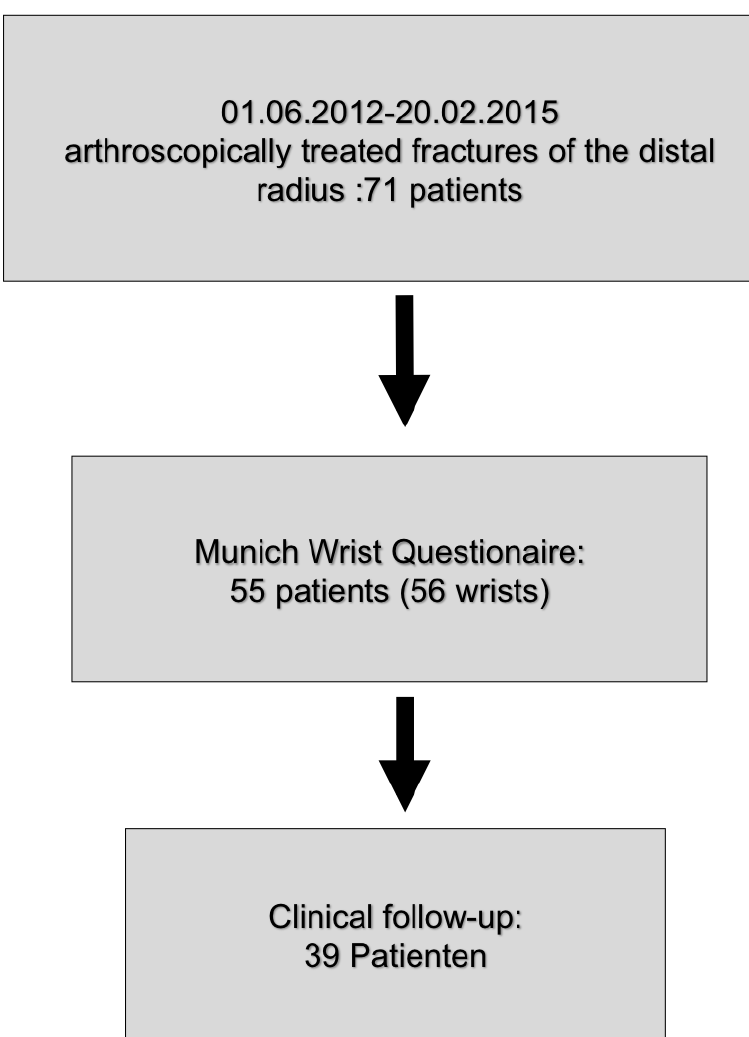
Figure 3. Study collective. In the period between June 2012 and February 2015, 71 wrists of 72 patients were operated on by arthroscopically assisted fracture treatment. Of these, 56 wrists from 55 patients were included in our study. In addition, 39 patients were examined clinically.